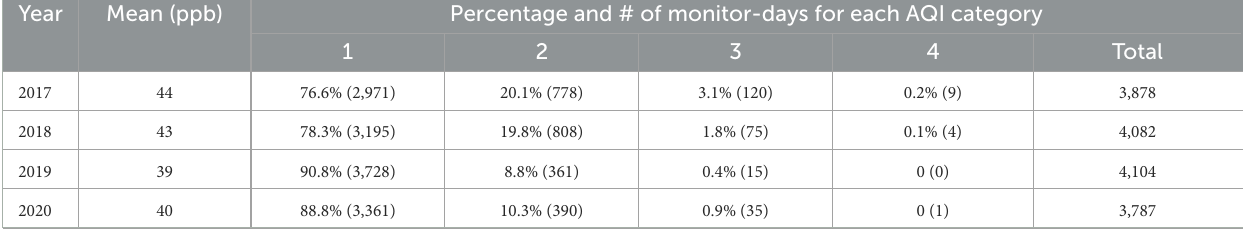
TABLE 1 Summary of the O 3 observations from May to September in 2017 to 2020 at 30 AQS sites in the PNW region. Note that daily AQI is computed using MDA8 O 3